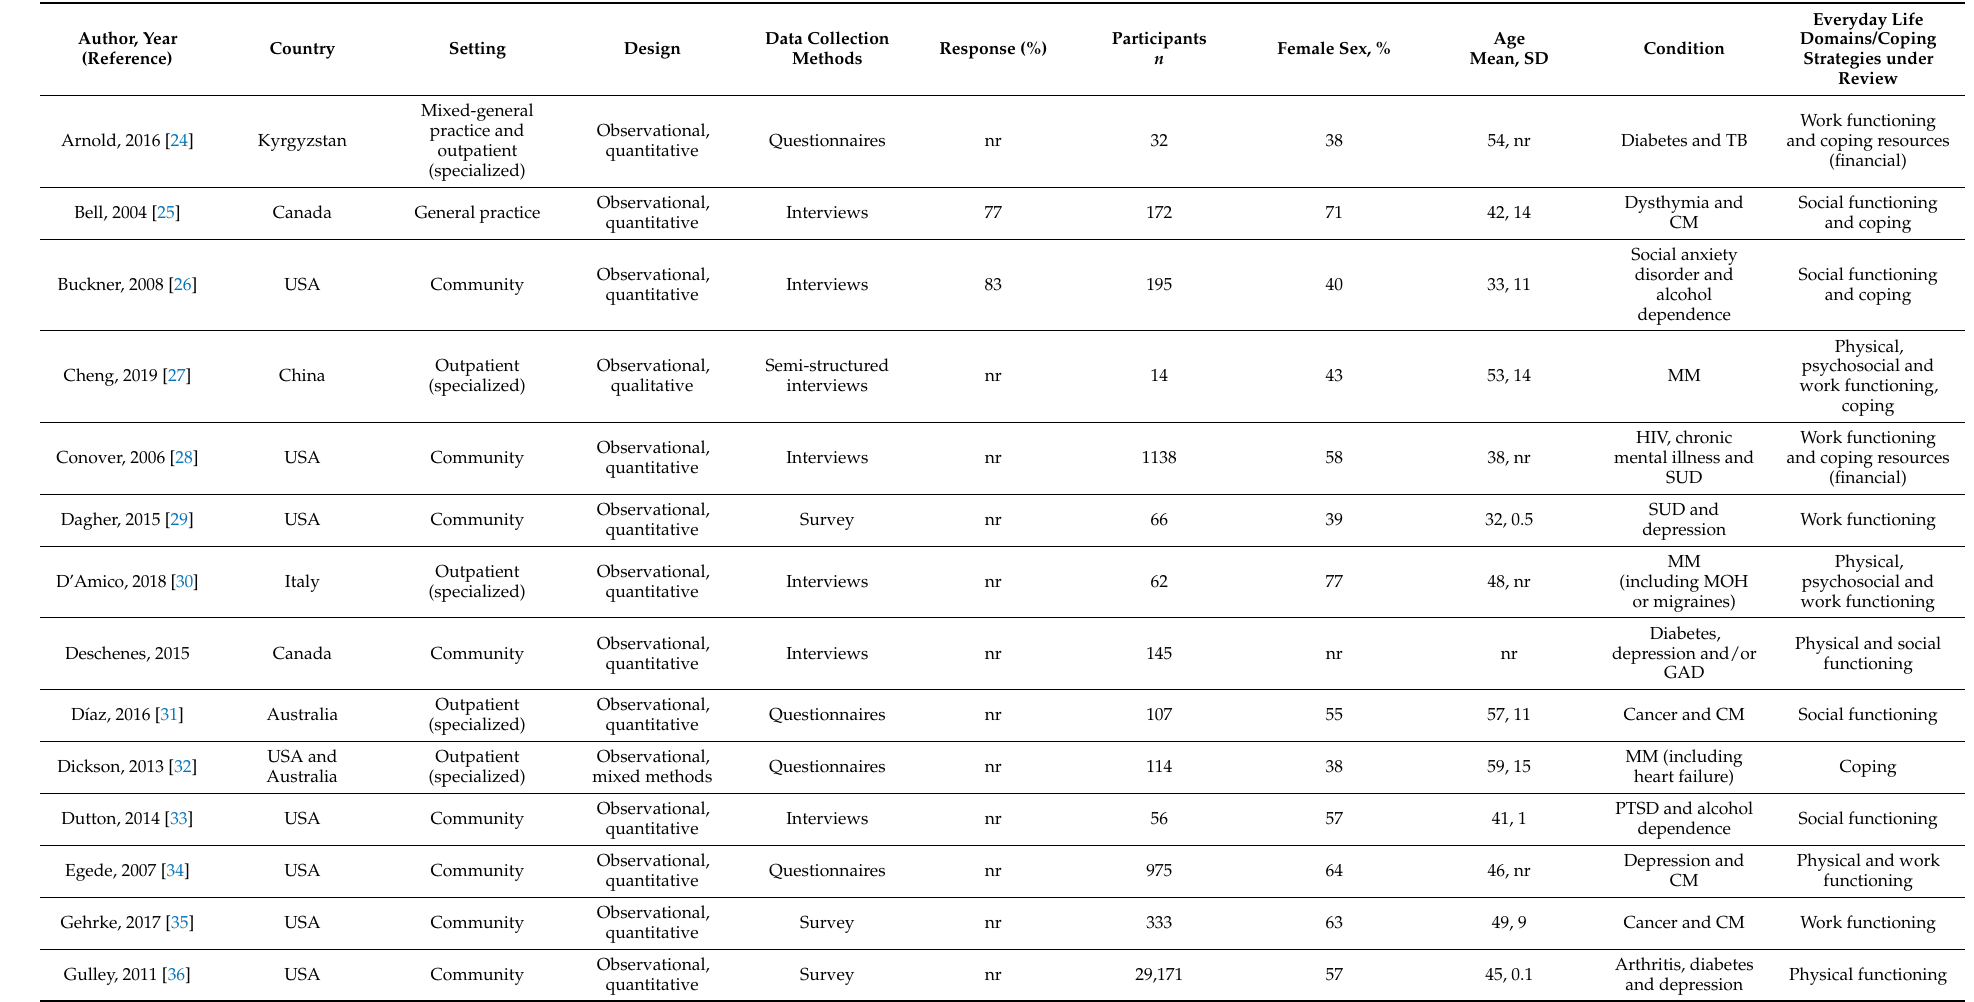
Table 1. Key characteristics of the included